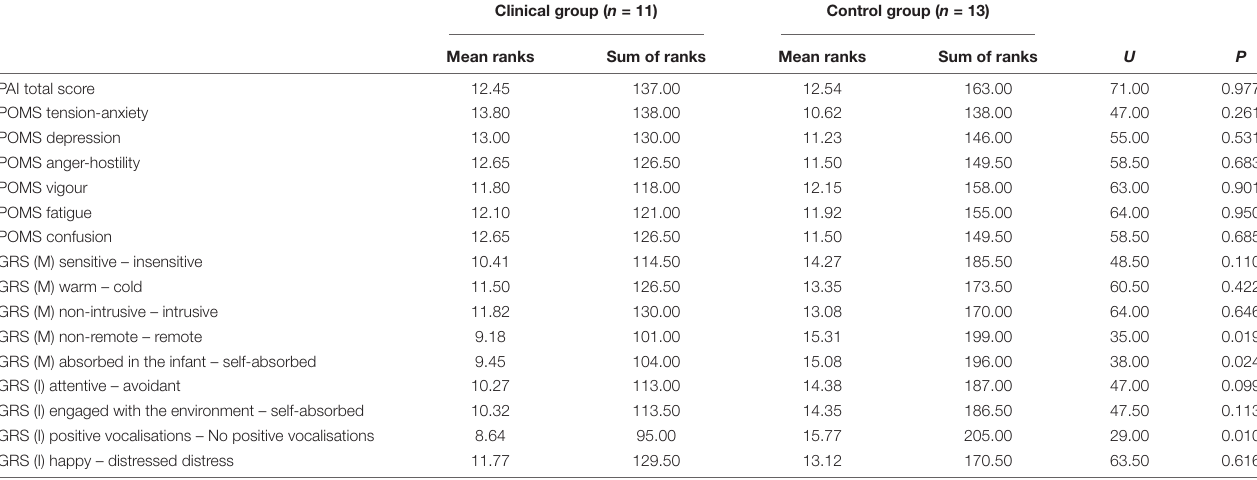
TABLE 2 | Statistical comparison between groups on PAI scores, POMS dimensions and GRS